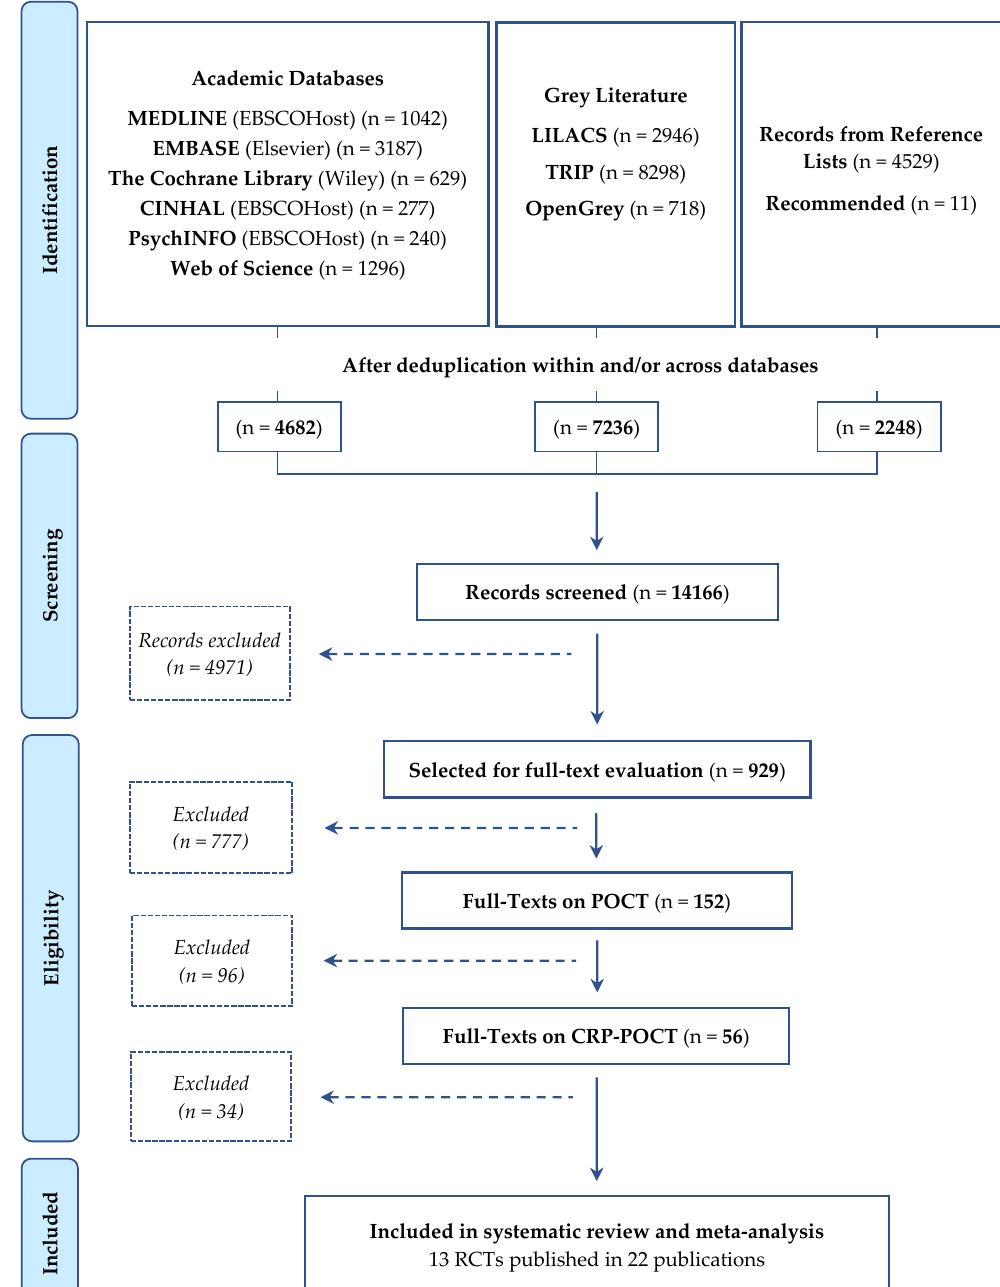
Figure 1. Study identification and process for selection of studies included in the review.